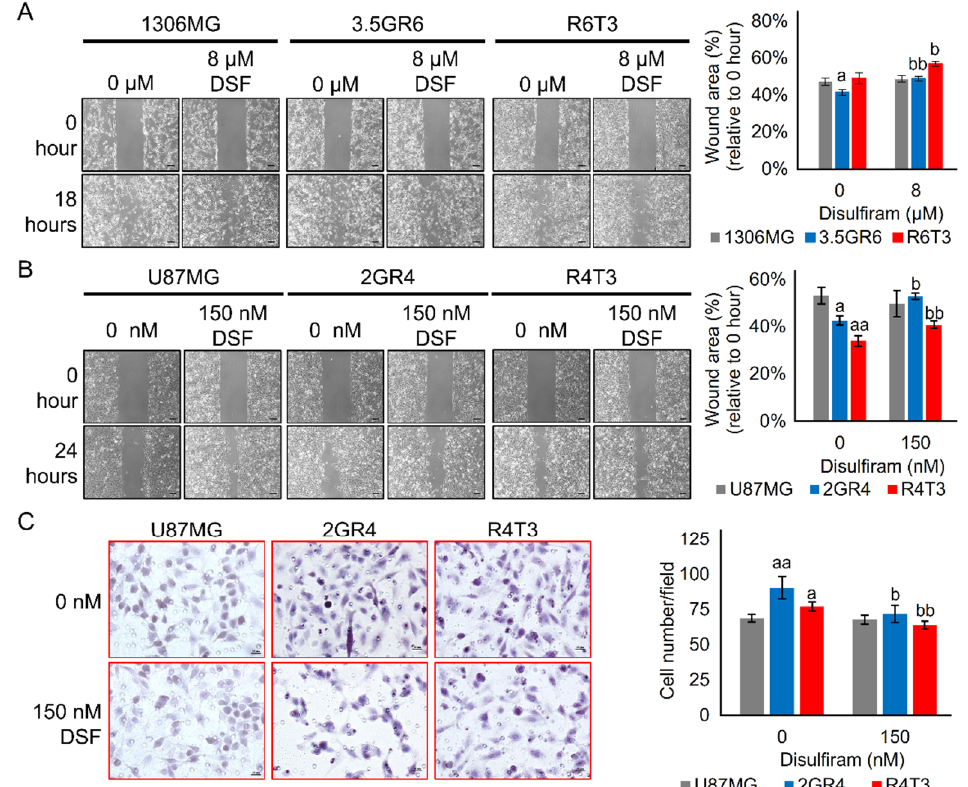
Figure 4. Disulfiram inhibited therapeutic resistance-induced cell mobility. A 20% dose of Disulfiram (DSF) growth inhibitor was selected. 0.1% DMSO was used as solvent control (labelled as 0 µ M). The cell mobility was evaluated using a two-dimensional (2D) wound healing assay and a three-dimensional (3D) Transwell assay. ( A ) Graphs of the wound and histogram showing the inhibitory effects of DSF on 2D cell mobility of 1306MG, radiation-resistant 3.5GR6, and radiation-TMZ-resistant R6T3; N = 3; scale bar = 100 µ m; ( B ) graphs and histogram showing the inhibitory effect of DSF on 2D cell mobility of U87MG, radiation-resistant 2GR4, and radiation-TMZ-resistant R4T3; N = 3; scale bar = 100 µ m; ( C ) graphs showing the migratory cells and histogram indicating the cell mobility of the inhibitory effect of DSF on 3D cell mobility of U87MG, radiation-resistant 2GR4, and radiation-TMZ-resistant R4T3; N = 5; scale bar = 20 µ m; mean ± SEM; a refers to a comparison with parental 1306MG or U87MG; b refers to a comparison with the control; a and b, p < 0.05; aa and bb, p < 0.01.